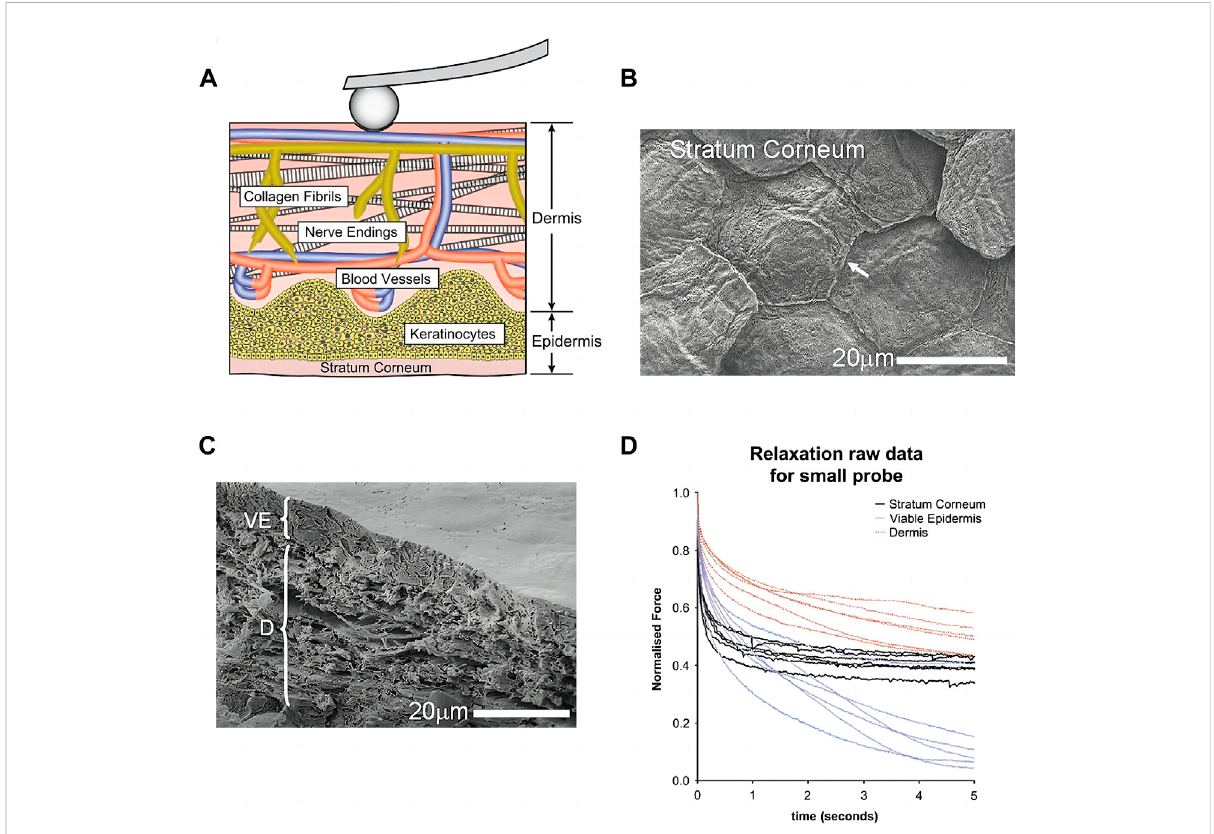
FIGURE 1 Biomechanical aspects of skin (A) Schematic of dermis: cells, blood vessels, nerves, and randomly oriented collagen fi bril network within the dermalmatrix.Reproducedwithpermissionfromref(Oftadehetal.,2018).Copyright2018Elsevier (B) Thestratumcorneum(SC)oftheskinshowing plate-like corneocytes (arrow) viewed by CryoSEM (C) the viable epidermis (VE) and Dermis (D) (D) Data from force relaxation experiments showed skin layers exhibit clear viscoelastic behavior with an initial fast drop in force followed by a clear plateau. (B – D) Reproduced with permission from ref (Crichton et al., 2011). Copyright 2011